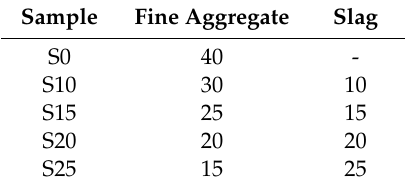
Table 1. The corresponding proportion of fine aggregate and slag (in weight %) in solidified products. Sample Fine Aggregate Slag S0 40 S10